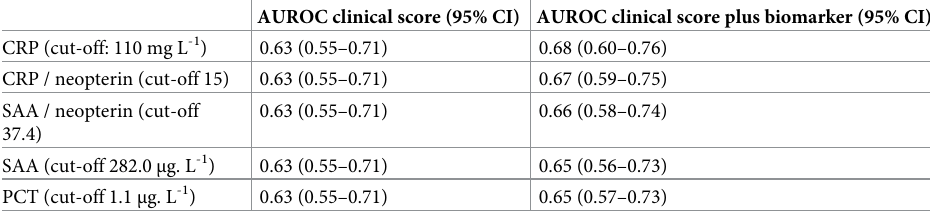
Table 3. AUROCs of a clinical score with and without biomarkers for the prediction of